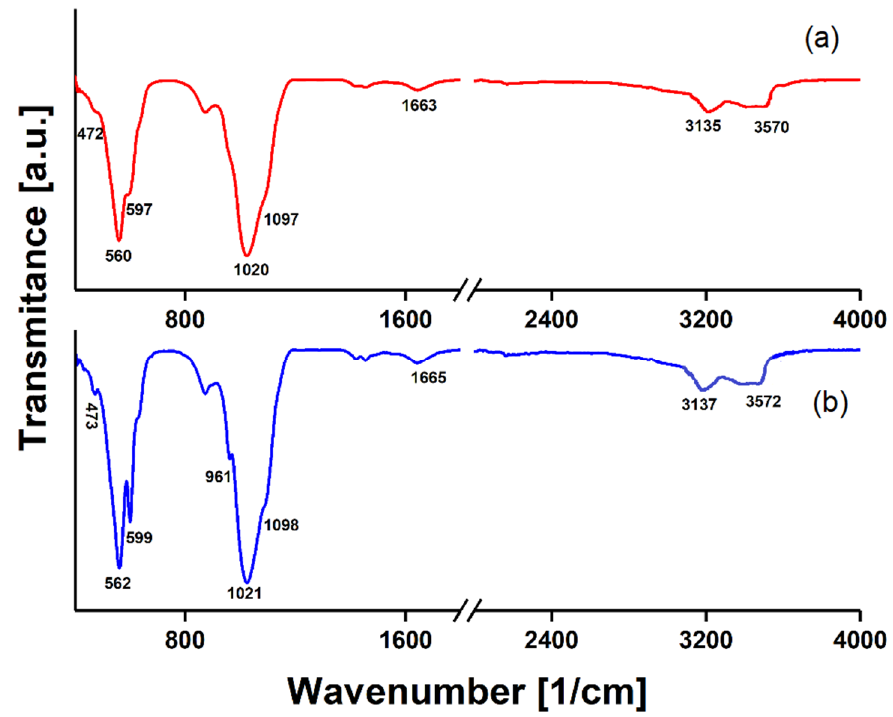
Figure 4. Typical FTIR spectra of N and Br co-doped HAp suspension ( a ), and NBrHAp thin films deposited on glass substrate ( b ).